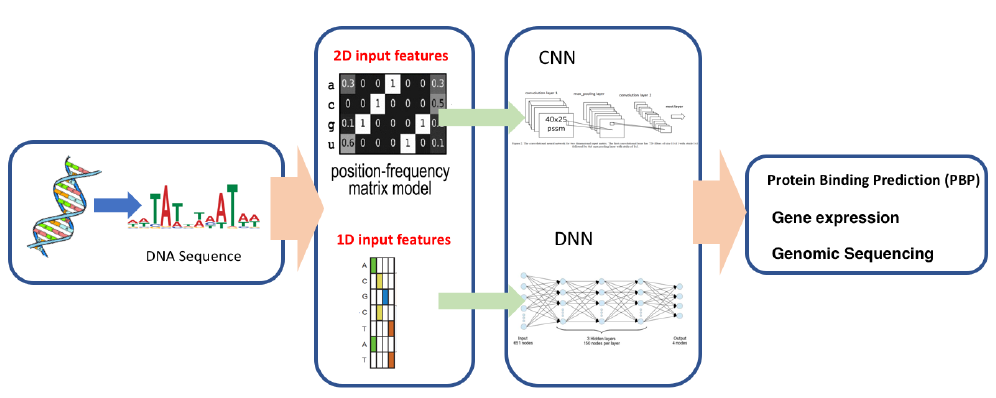
Figure 8. Around the